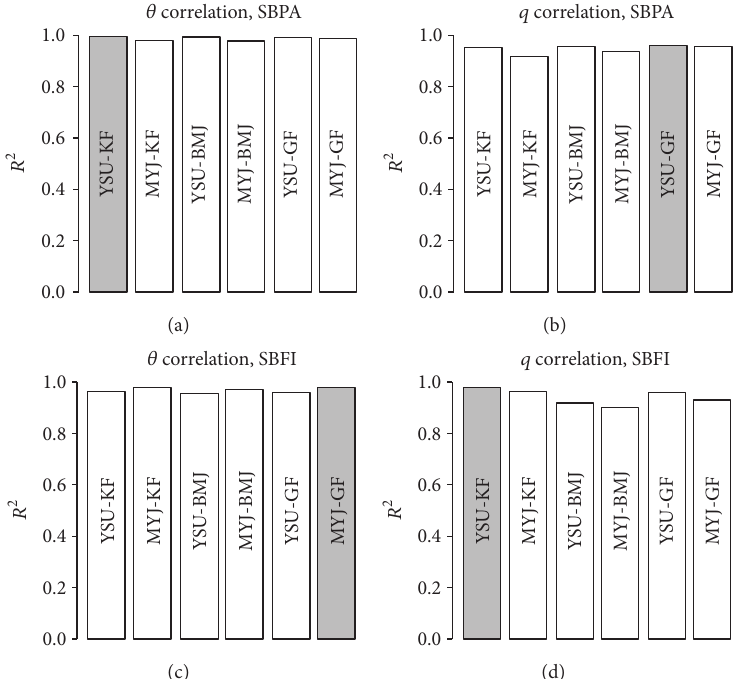
Figure 7: Pearson correlation coefficients between simulated and observed 0–3 km profiles of potential temperature [(a) and (c)] and water vapor mixing ratio [(b) and (d)] at SBPA [(a)-(b)] and SBFI [(c)-(d)] sites at 12Z 21 October 2008. Shaded bars indicate the simulations with highest correlation coefficients.